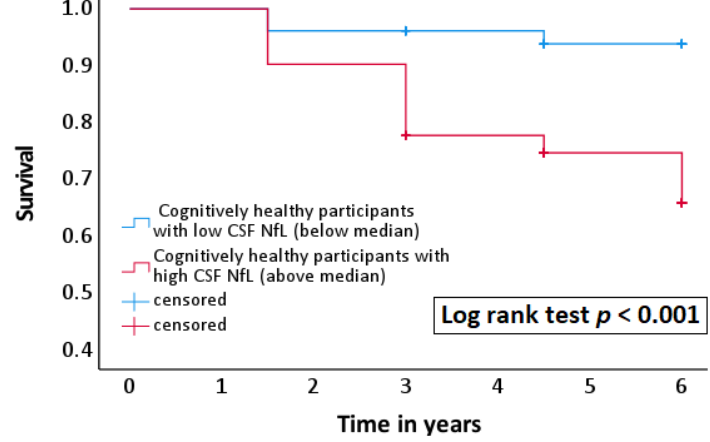
t-test. Abbreviations: AD: Alzheimer’s disease; APOE : apolipoprotein E; CDR: clinical dementia rating; CSF: cerebrospinal fluid; LP: lumber puncture; NfL: neurofilament light.